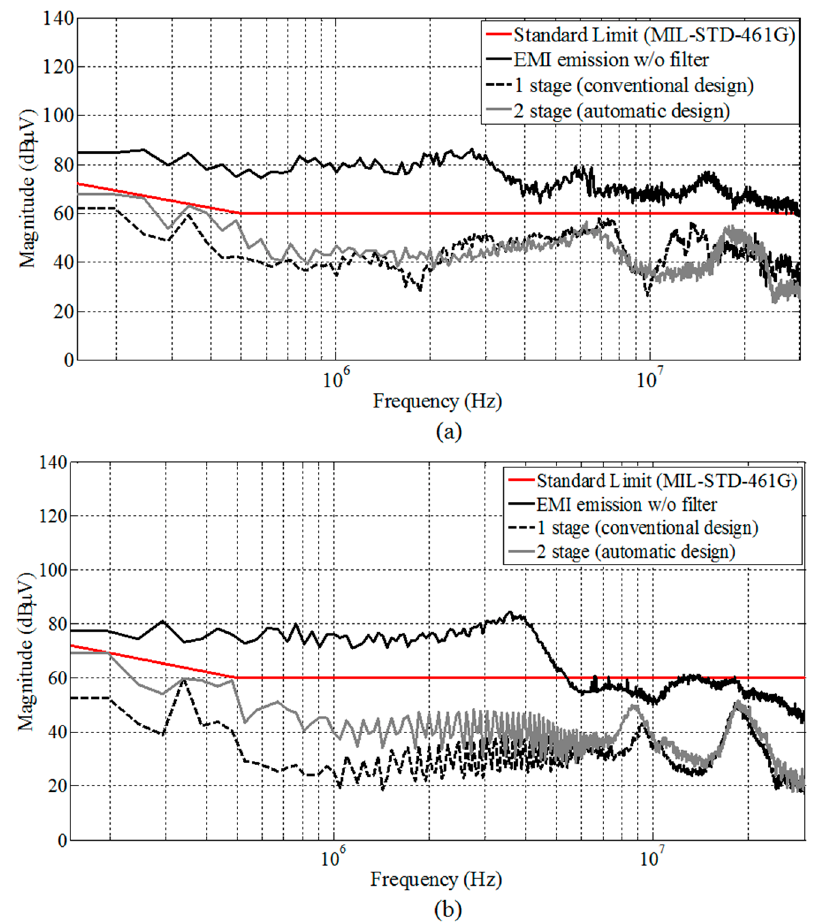
Figure 7. Measured EMI with and without EMI filters ( a ) case study #1; ( b ) case study #2.